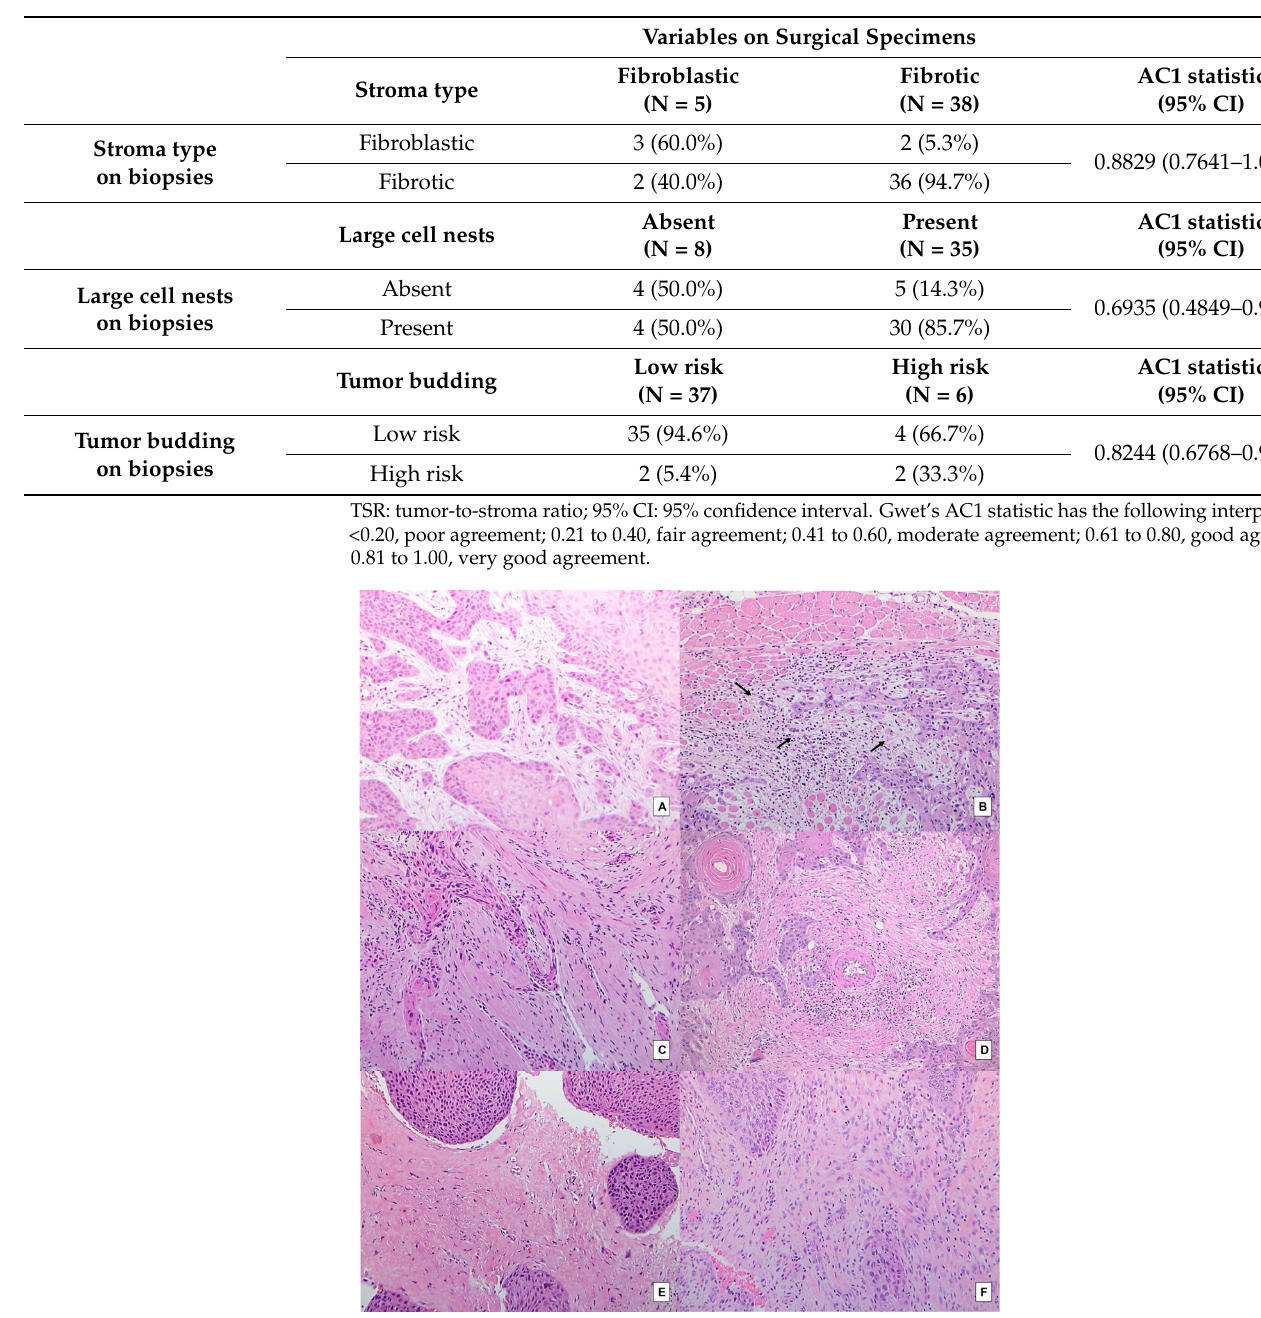
Figure 1. Paired biopsies and surgical specimens: ( A ) LSCC biopsy with a high TSR (stroma-poor case), displaying tumor buds in a fibroblastic stroma (H&E, original magnification 100×); ( B ) surgi- cal specimen of the same case as A, in which tumor buds are evident at the front of invasion of the tumor (arrows) in a fibroblastic stroma; smooth muscle can be seen at the top of the image (H&E, original magnification 100×); ( C ) biopsy of a low TSR (stroma-rich case) (H&E, original magnifica- tion 100×); ( D ) paired surgical specimen (H&E, original magnification 100×); ( E ) biopsy of low TSR (stroma-rich case), large cell nests and fibrotic stroma (H&E, original magnification 100×); ( F ) paired surgical specimen (H&E, original magnification 100×).